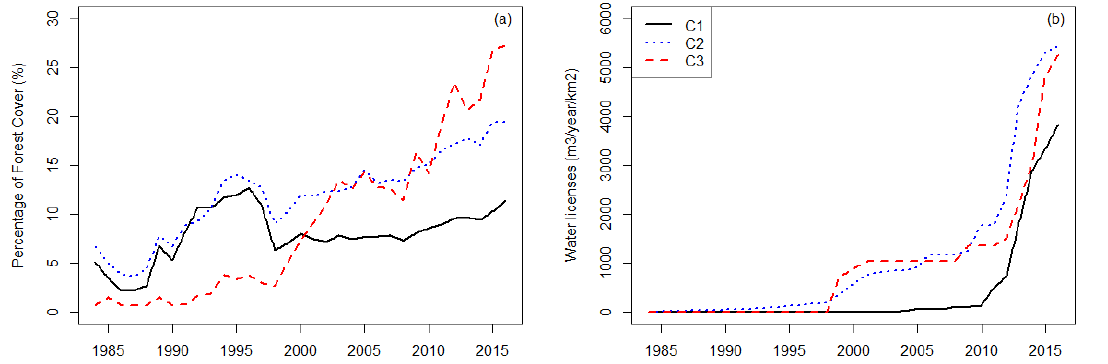
Figure 2. ( a ) Percentage of sub-catchment area used for forestry. ( b ) Water